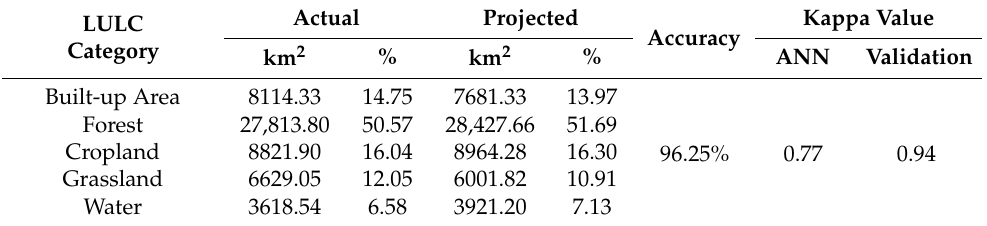
Figure 8. ( a ) Actual LULC 2020 and ( b ) projected LULC 2020. Table 15. Actual and projected LULC of 2020